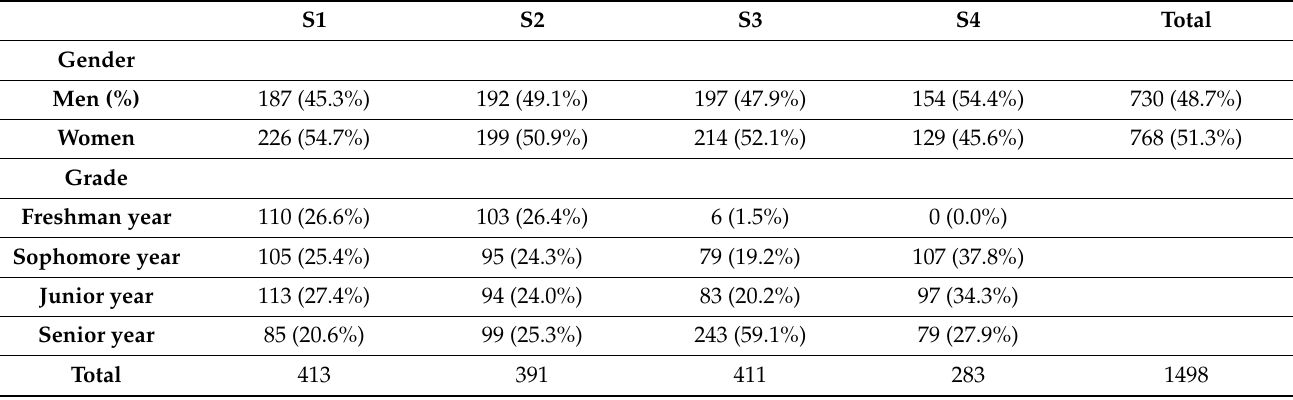
Table 1. Sample characteristics ( n = 1498).